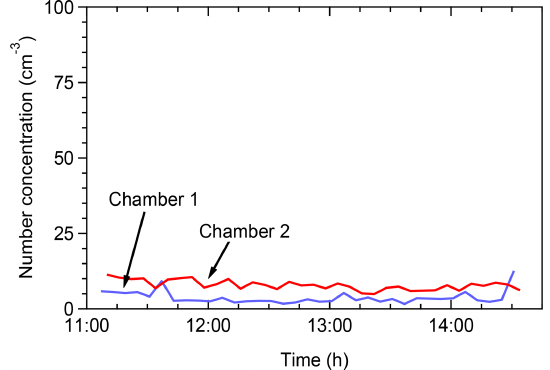
Figure 2. Total particle number concentrations as a function of time when the chambers were filled with clear air in the field for leak check of the